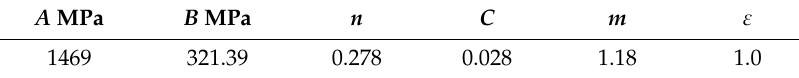
Table 6. Johnson–Cook constitutive model parameters for AISI H13 steel [32].